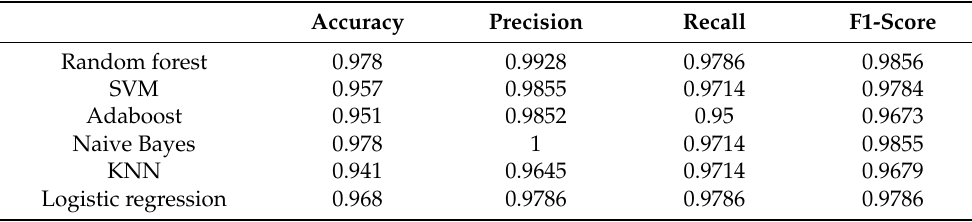
Table 2. Comparison of evaluation results of the